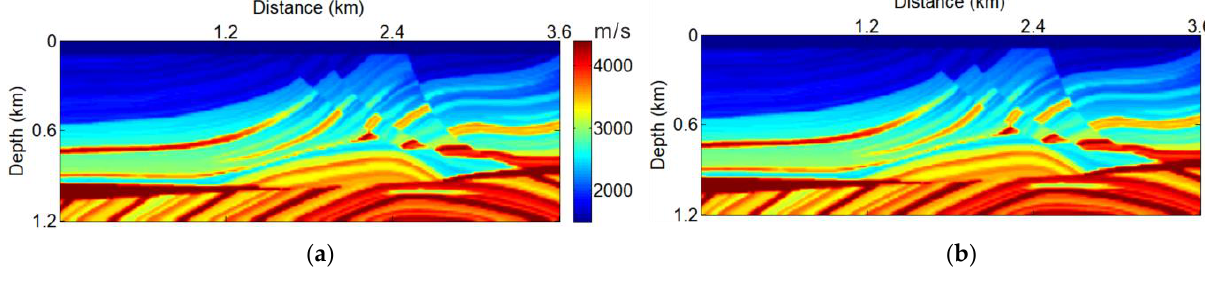
Figure 4. True velocity models; ( a ) V p ; ( b ) V s . Figure 5. Initial velocity models; ( a ) V p ; ( b ) V s .